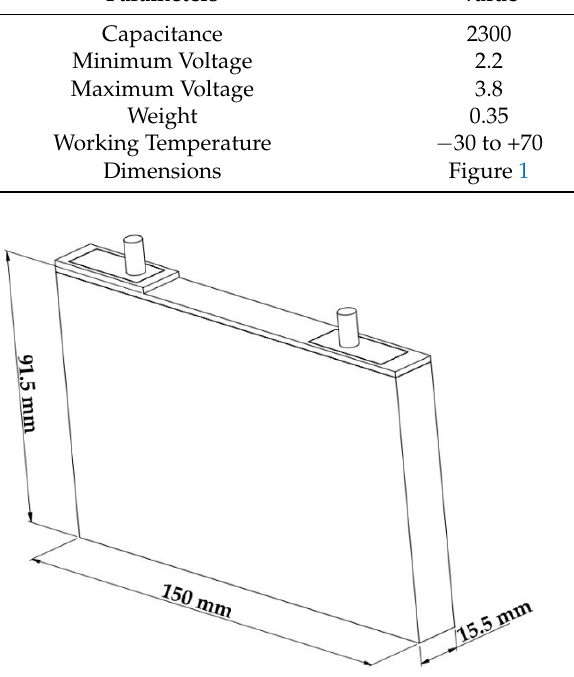
Table 1. Specifications of the lithium-ion capacitor. Table 2. Characteristics of different domains of the LiC cell.